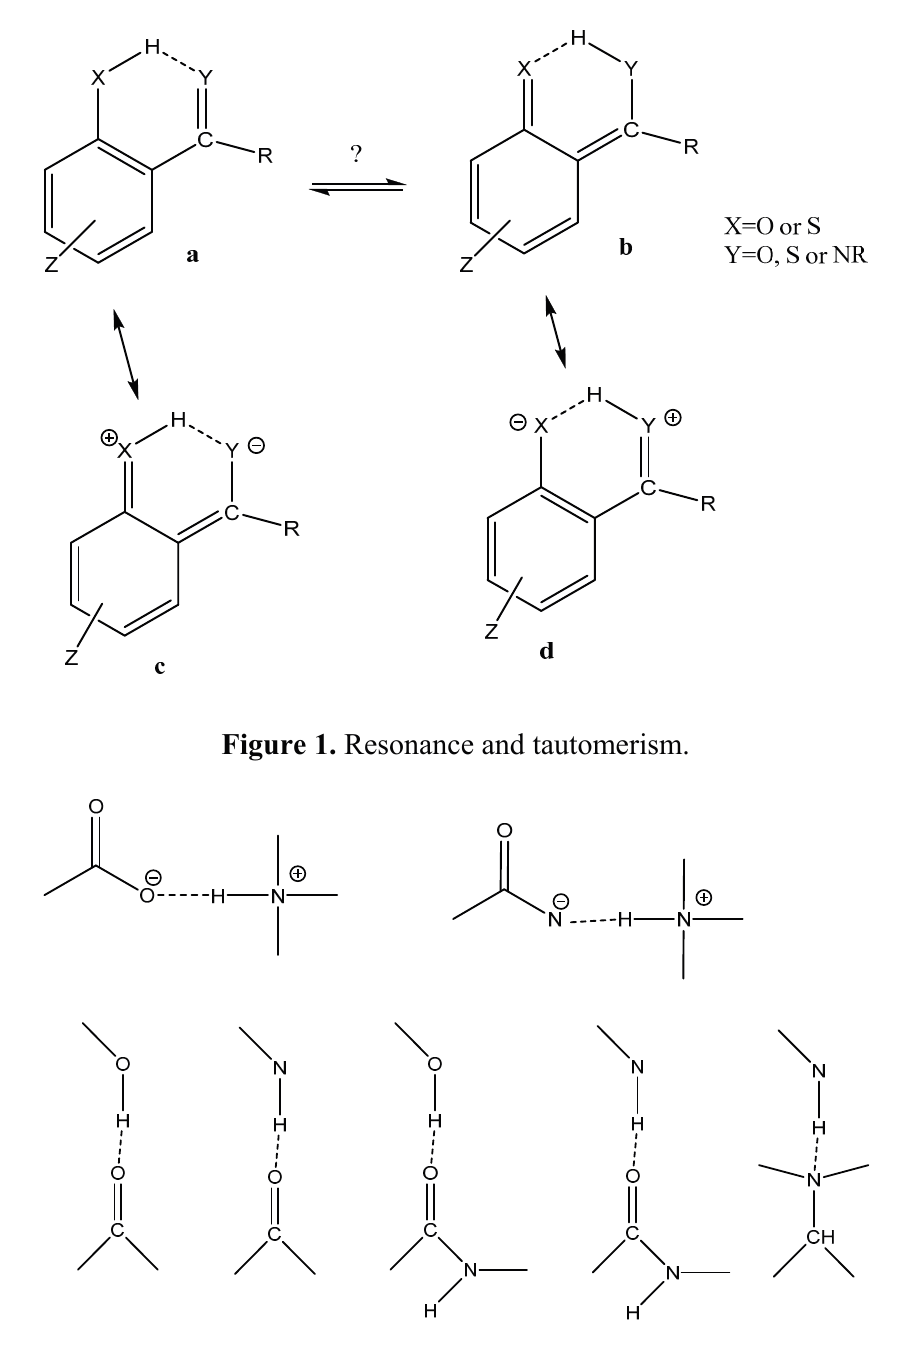
Figure 2. Hydrogen bond